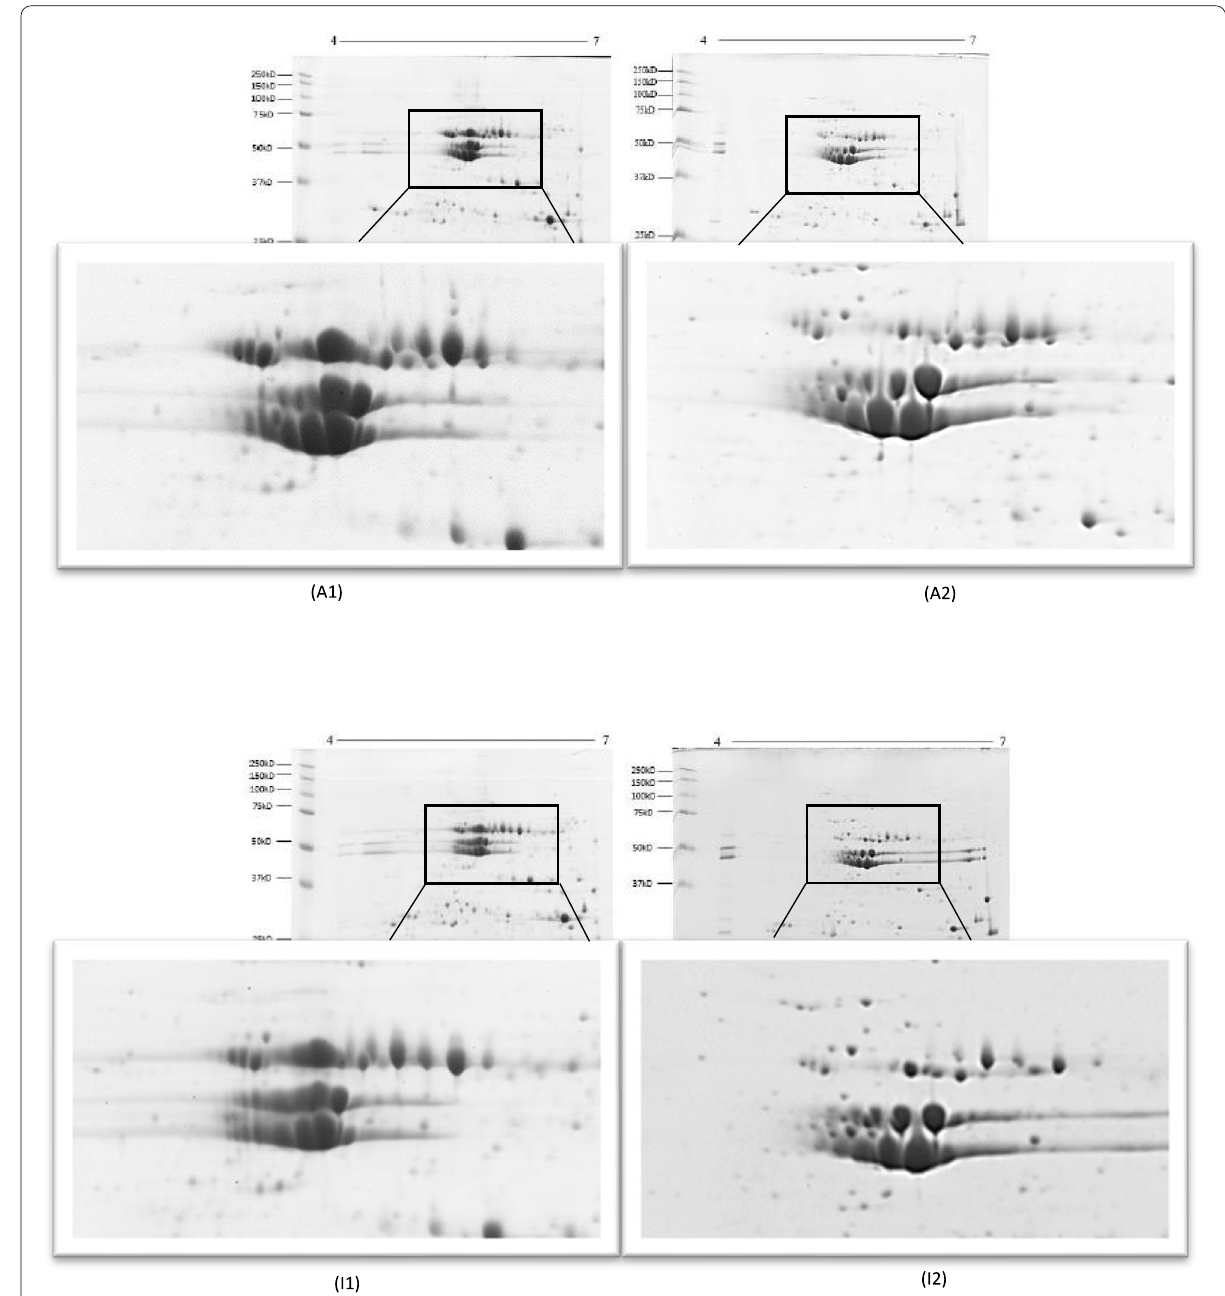
Fig. 3 Highlights of clean-up effects in comparative maps of protein profile from grains of two Brazilian cowpea ( Vigna unguiculata ) cultivars. (A) BRS Aracê and (I) BRS Itaim. (A1) and (I1) without Clean-up; (A2) and (I2) with Clean-up. 250 μg of proteins were separated using 13 cm linear IEF, pH 4–7 IPG strips for the first dimension and 125 g L − . 1 SDS-PAGE gels for the second dimension. Gels were stained with Coomassie Brilliant Blue